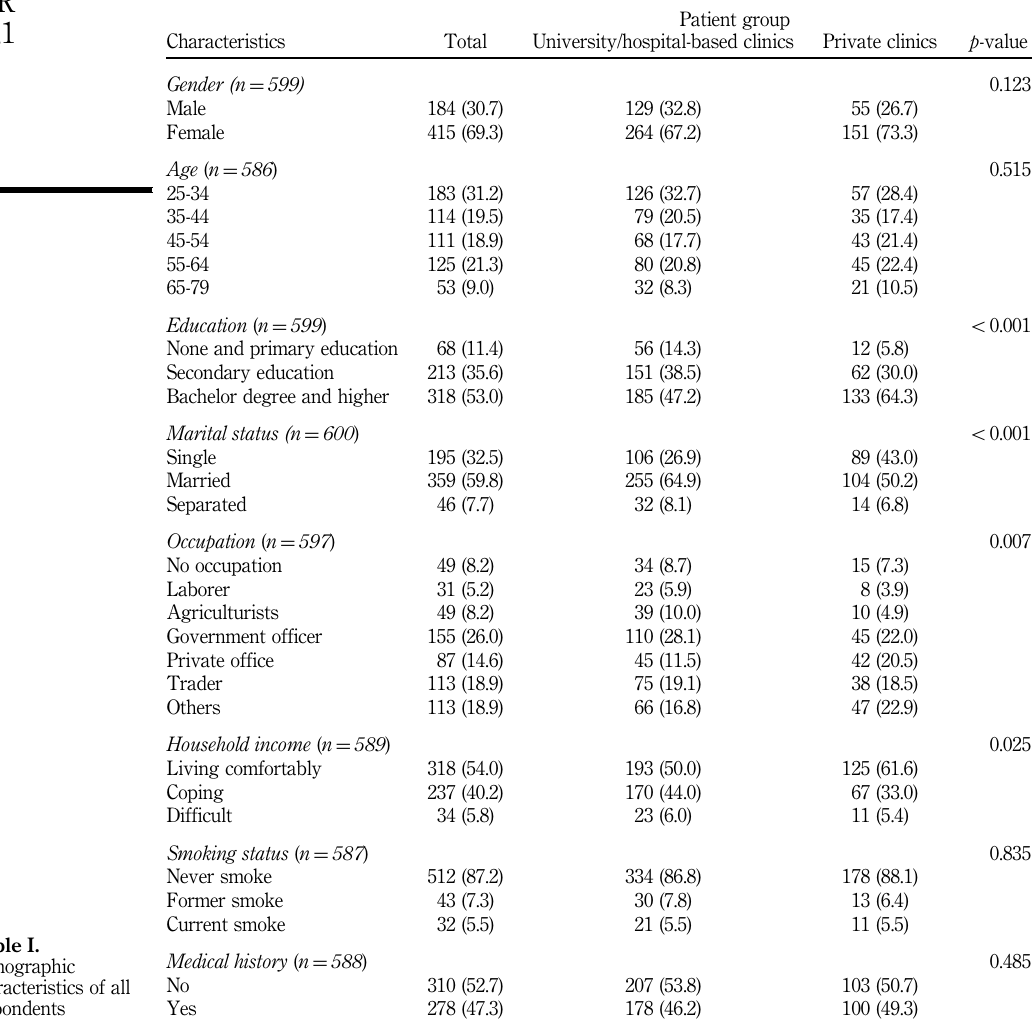
characteristics of all